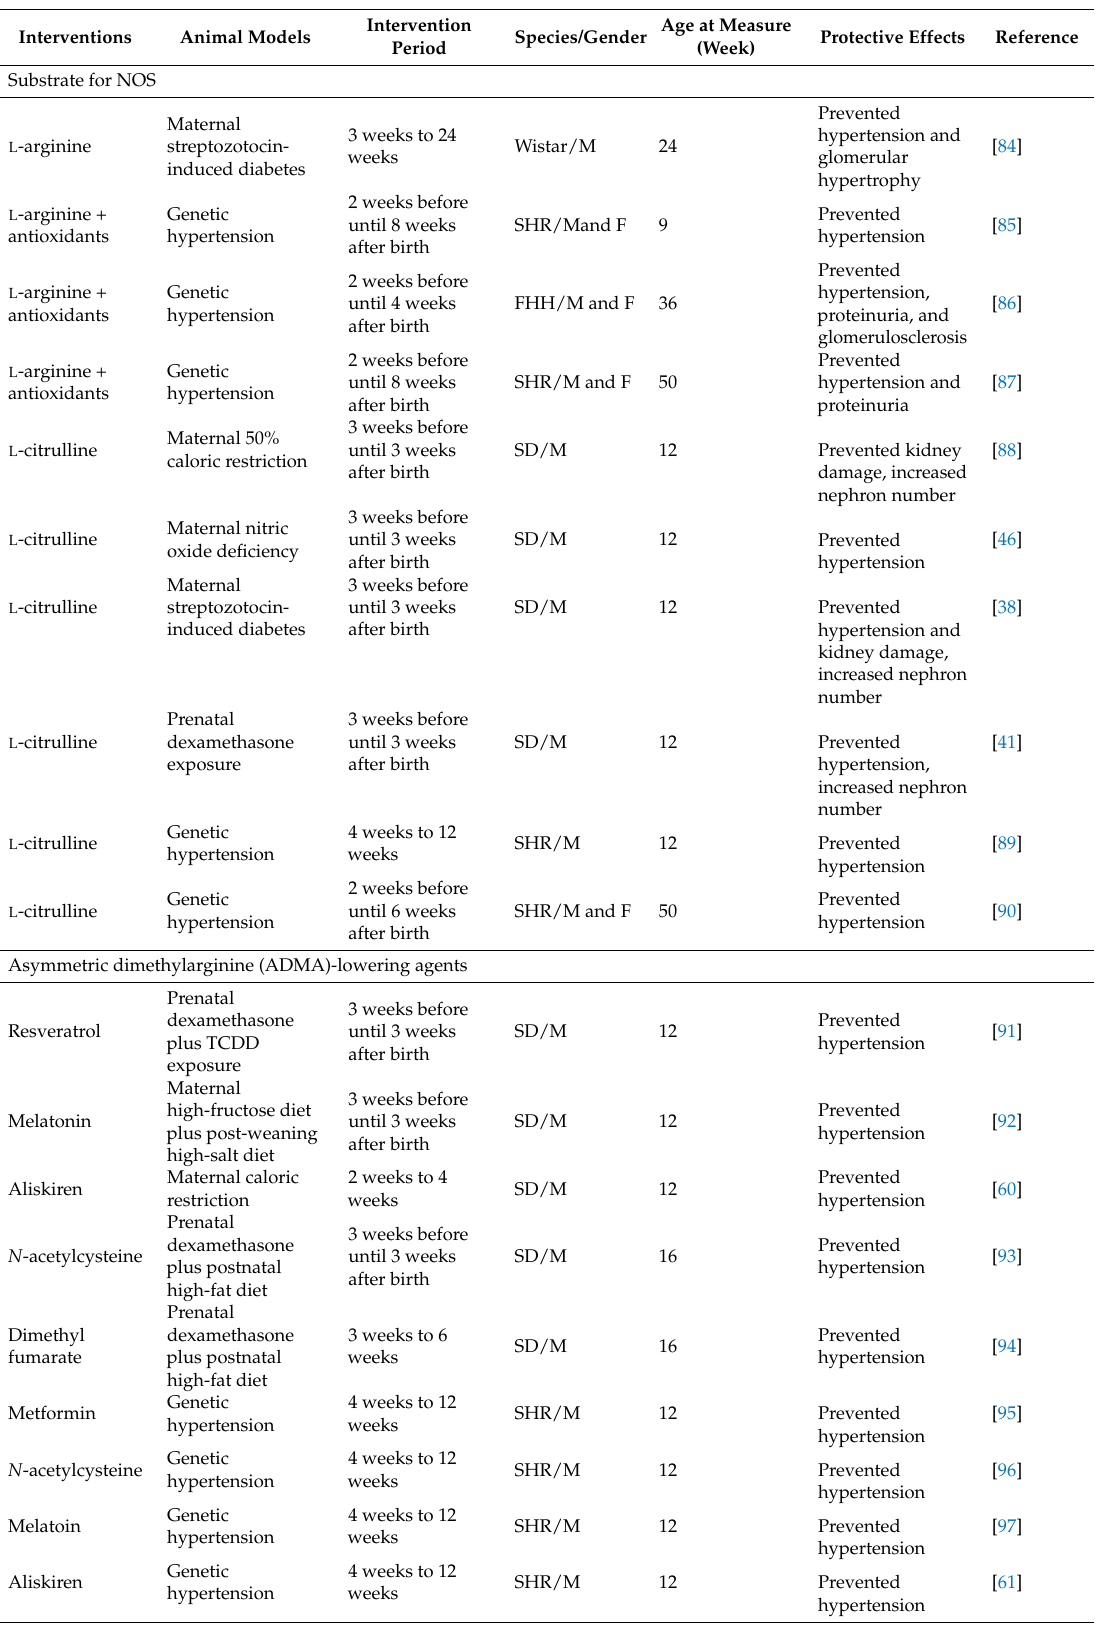
Table 1. Reprogramming strategies targeting the NO pathway to prevent hypertension and kidney disease of developmental programming in animal models. Intervention Age at Measure Protective Effects Animal Models Species/Gender (Week) Period